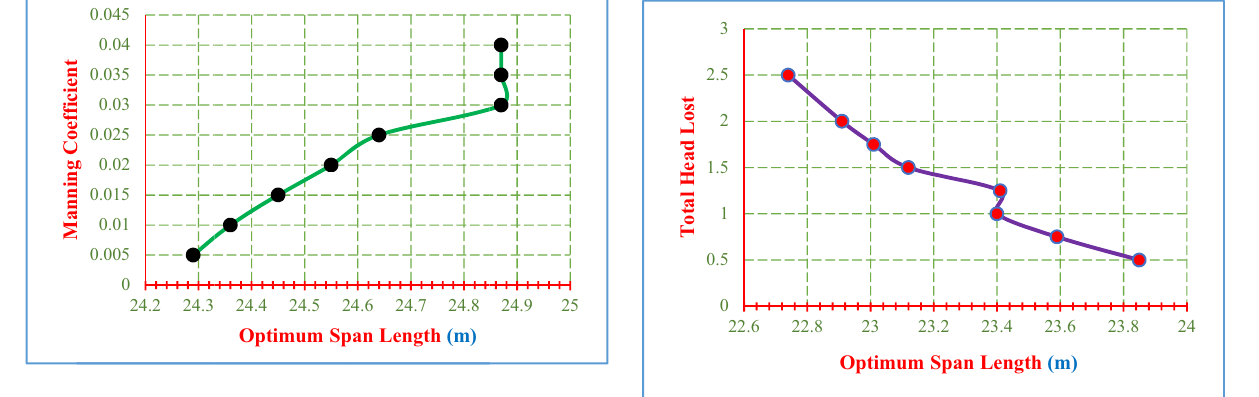
Figure 10: Manning coe ffi cient vs safe span length.